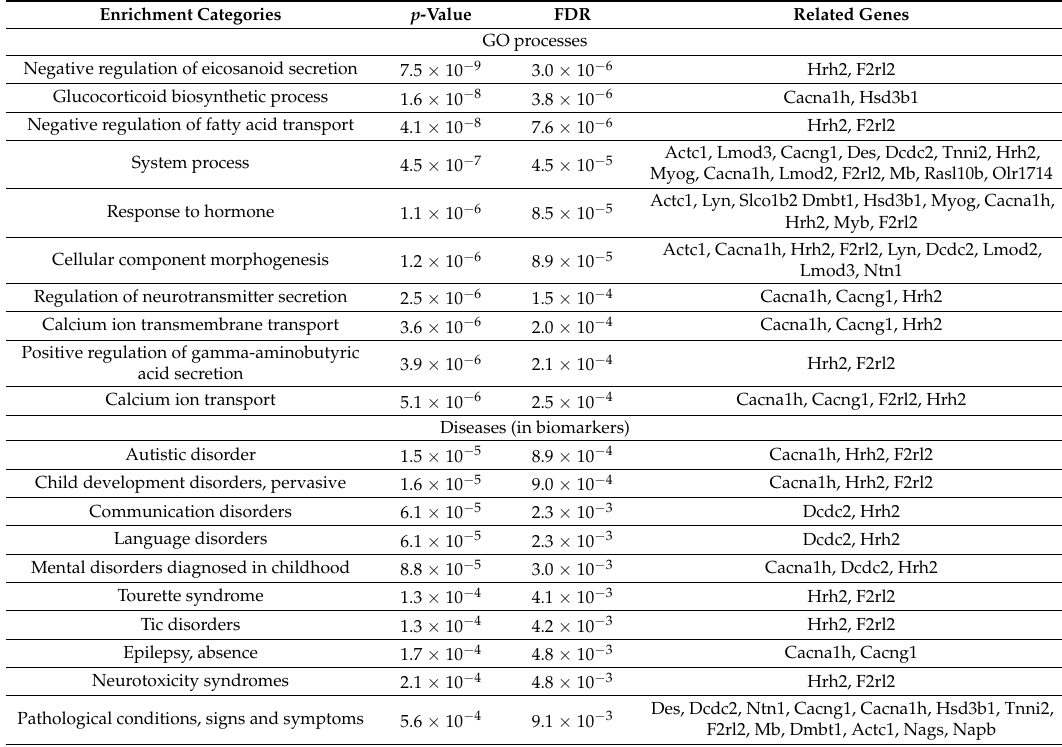
Table 6. MetaCore enrichment analysis of DE genes in